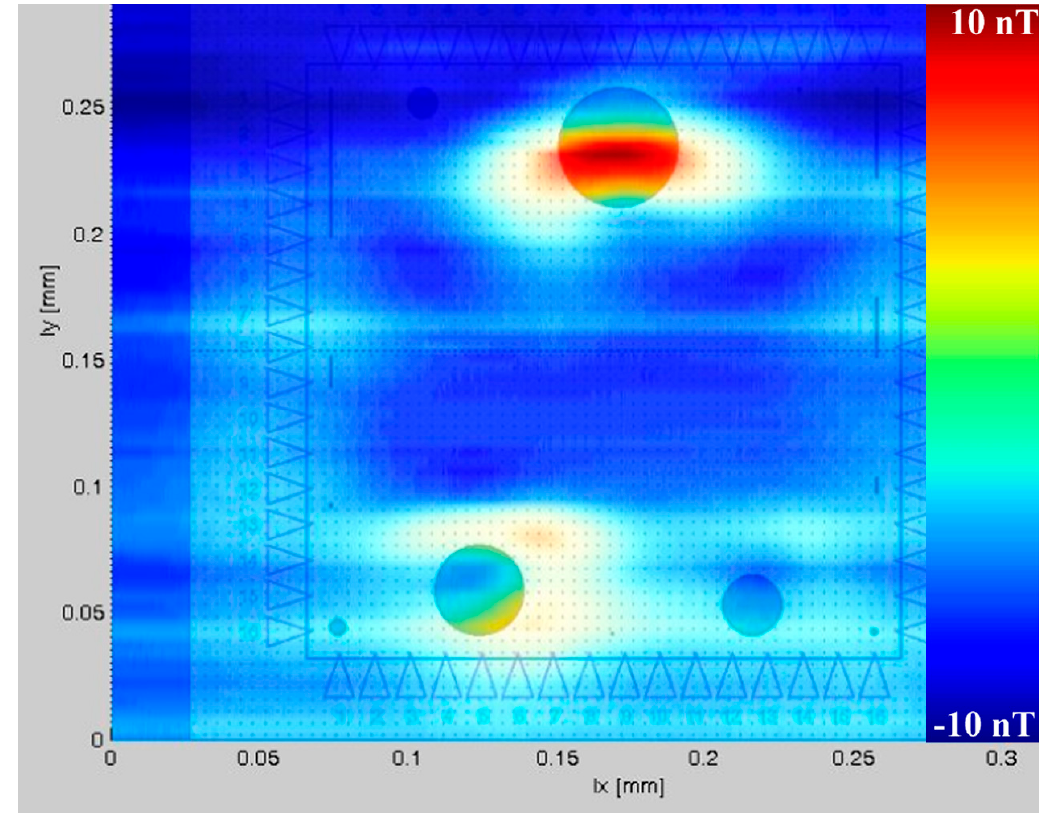
Figure 9. Magnetic field distribution of the demagnetized state of a 30-nm-thick Co film (contours showing the Co pattern have been added to the picture) prepared on a 50-nm-thick SiN membrane. The color scale represents magnetic fields of between − 10 nT (blue) and 10 nT (red). Signals recorded from the magnetic domain structure of 40 µm, 30 µm and 20 µm dots are observable.